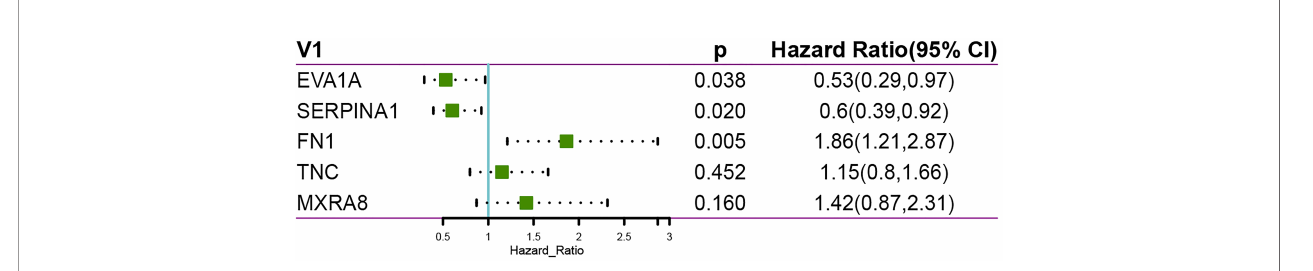
FIGURE 7 | Multi-factor COX regression analysis showing EVA1A, SERPINA1 and FN1 as independent prognostic